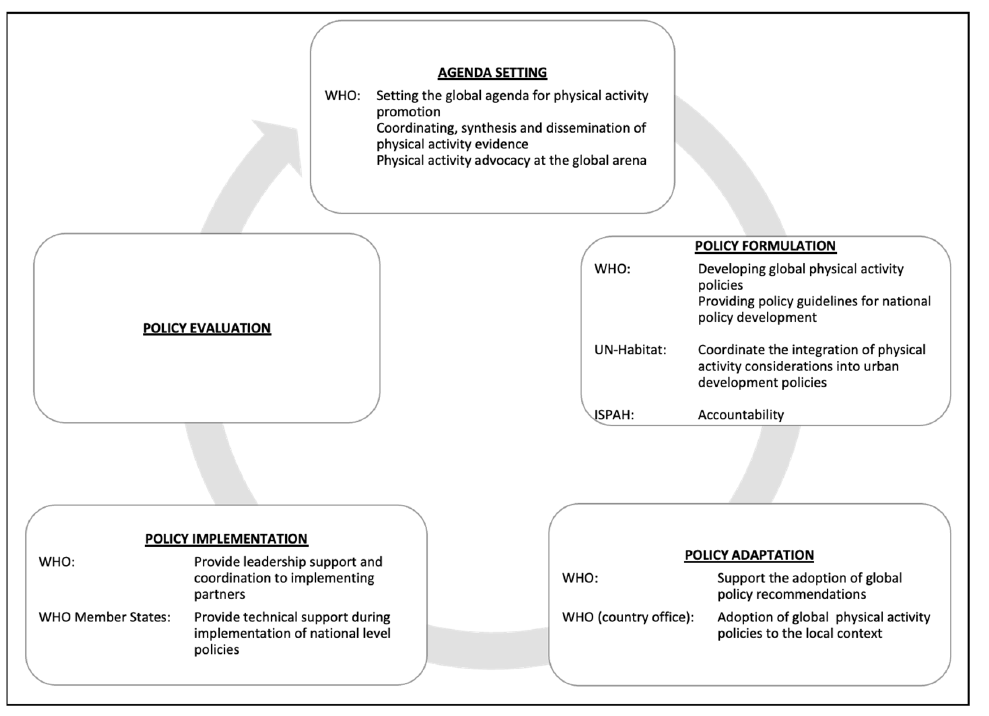
Figure 3. Highlighted stakeholder roles in the global physical activity policy development cycle. The figure indicates the five stages of policy development (Agenda Setting, Policy Formulation, Policy Adoption, Policy Implementation, and Policy Evaluation), stakeholders involved, and their perceived roles as indicated in reviewed policies. Abbreviations are as follows: WHO—World Health Organization, UN-Habitat—United National Human Settlements Programme., ISPAH- International Society for Physical Activity and Health.